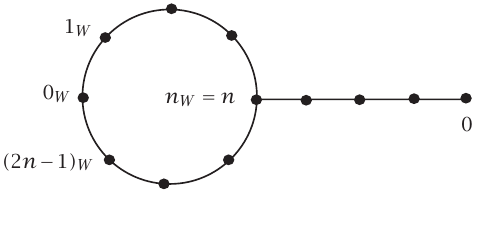
Figure 3.1 . The lollipop P in Theorem